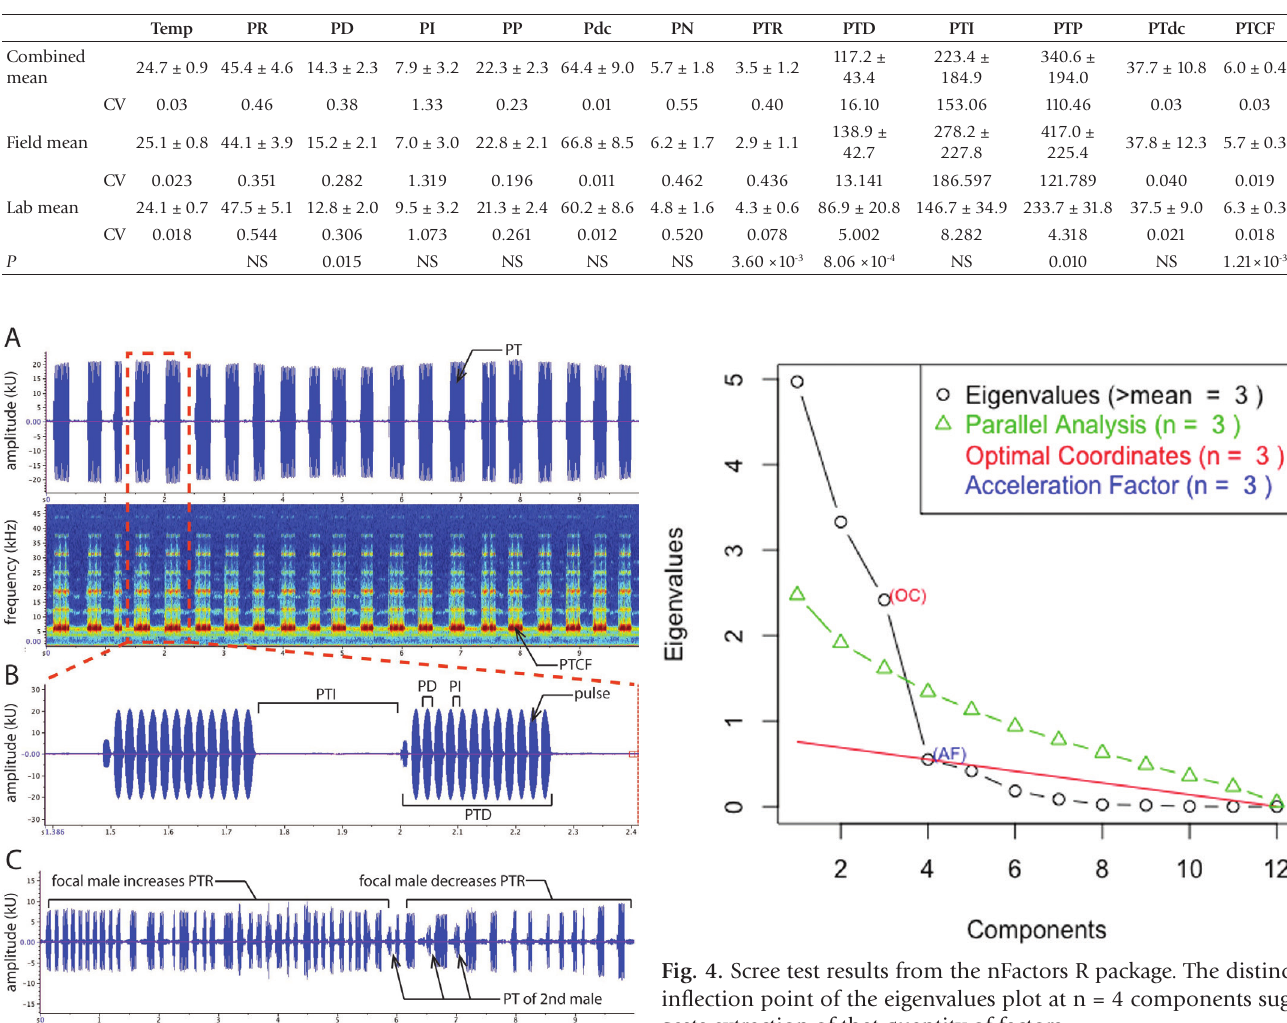
Table 1. Song character descriptive statistics. All means are reported ± standard deviation with coefficients of variation (CVs) below. The P row shows P -value results from a MANOVA test that compared recordings between field and laboratory conditions. Temperatures between these conditions were compared with a 2-sample t -test.